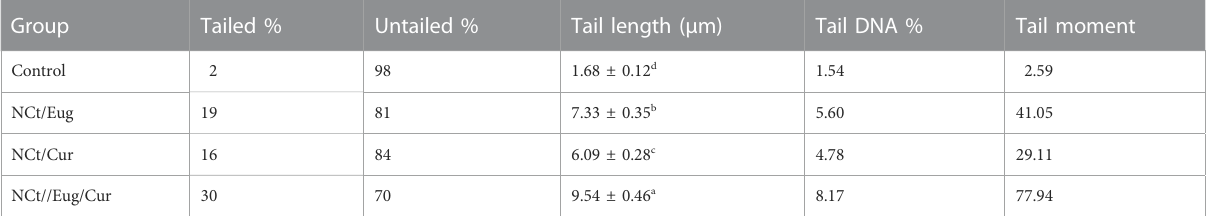
TABLE 2 Software analysis of comet images for treated CaCo2 cells with IC 50 from nanochitosan/eugenol (NCt/Eug), nanochitosan/curcumin (NCt/Cur), and nanochitosan/eugenol/curcumin (NCt/Eug/Cur) composites, compared to control (untreated) cells. Group Tailed % Untailed